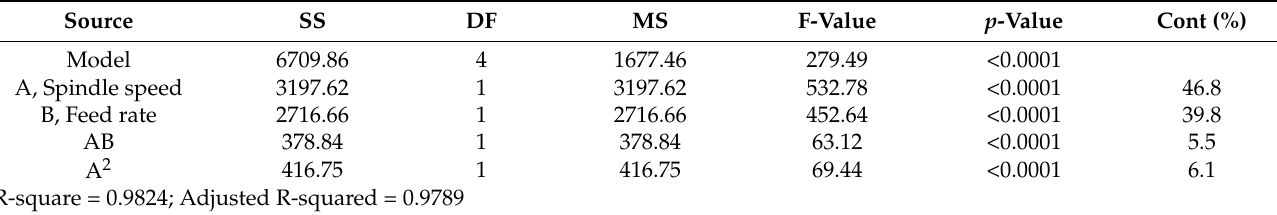
Table 5. ANOVA results for thrust.